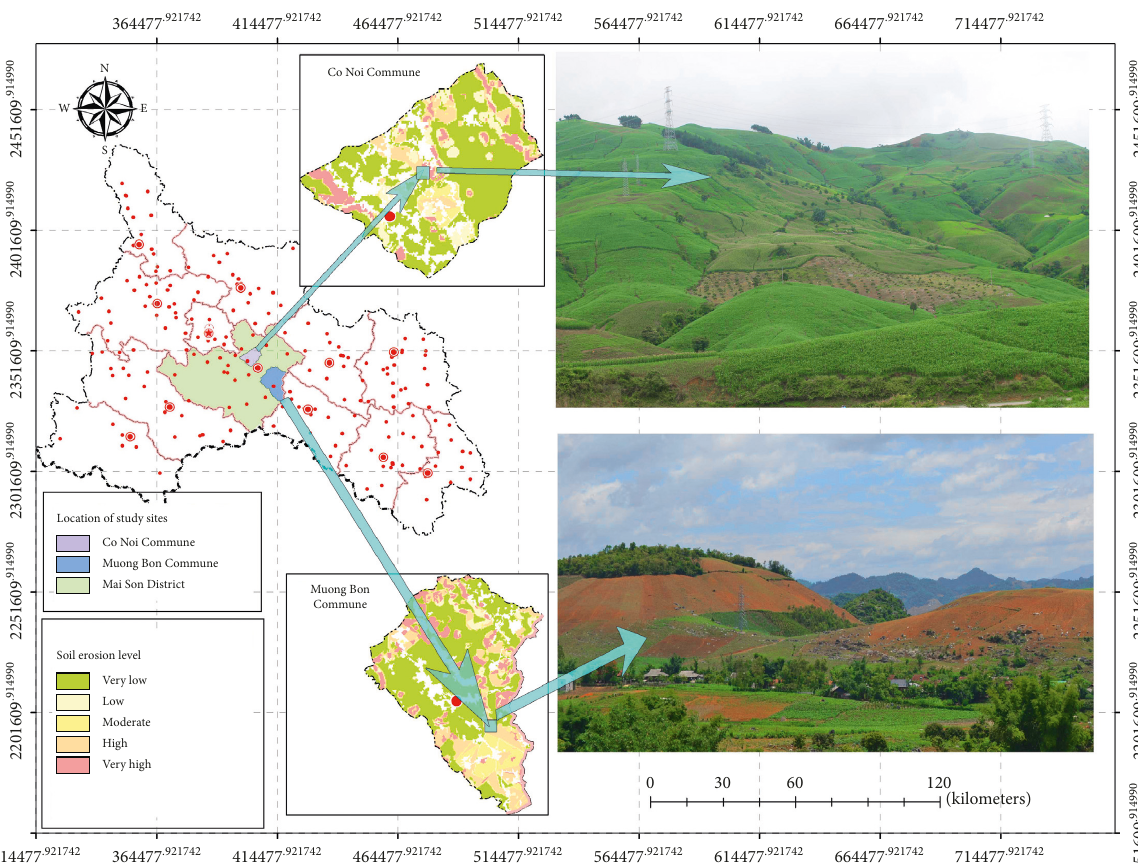
Figure 4: Sites monitoring, assessing soil erosion, and studying solutions to mitigate soil loss. Table 5: Soil loss levels and areas in Mai Son district. Levels of soil